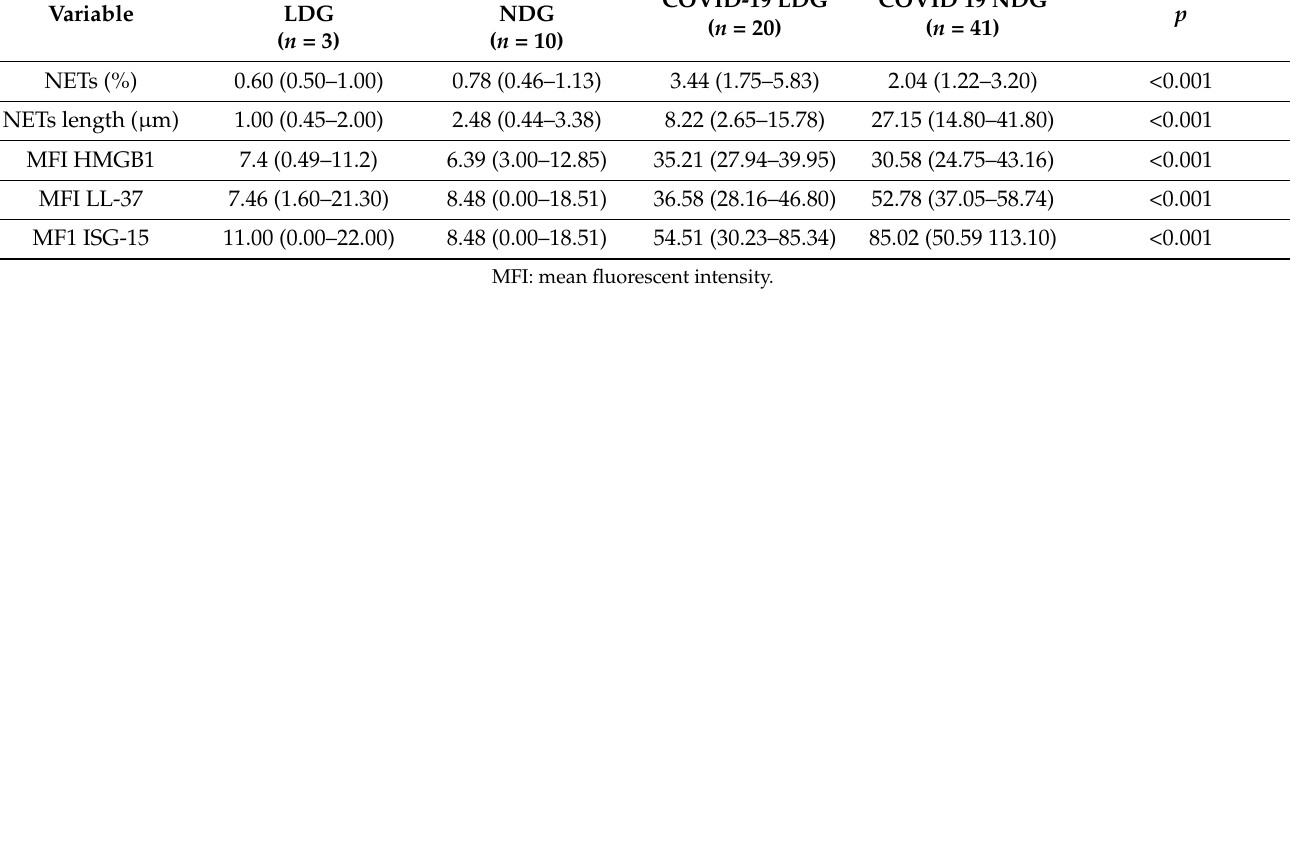
Table 2. Amount of NETs and their protein cargo measured by confocal tively.